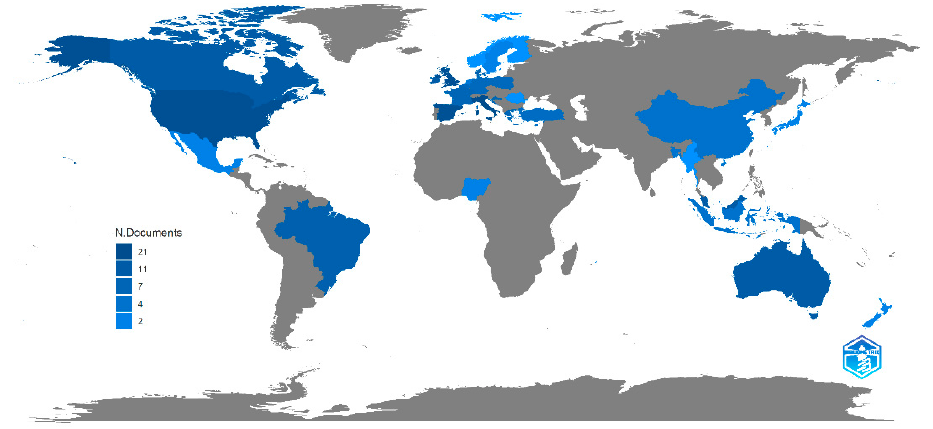
Figure 4. Scientific production by country related to the term “marine spatial data infrastructure”.